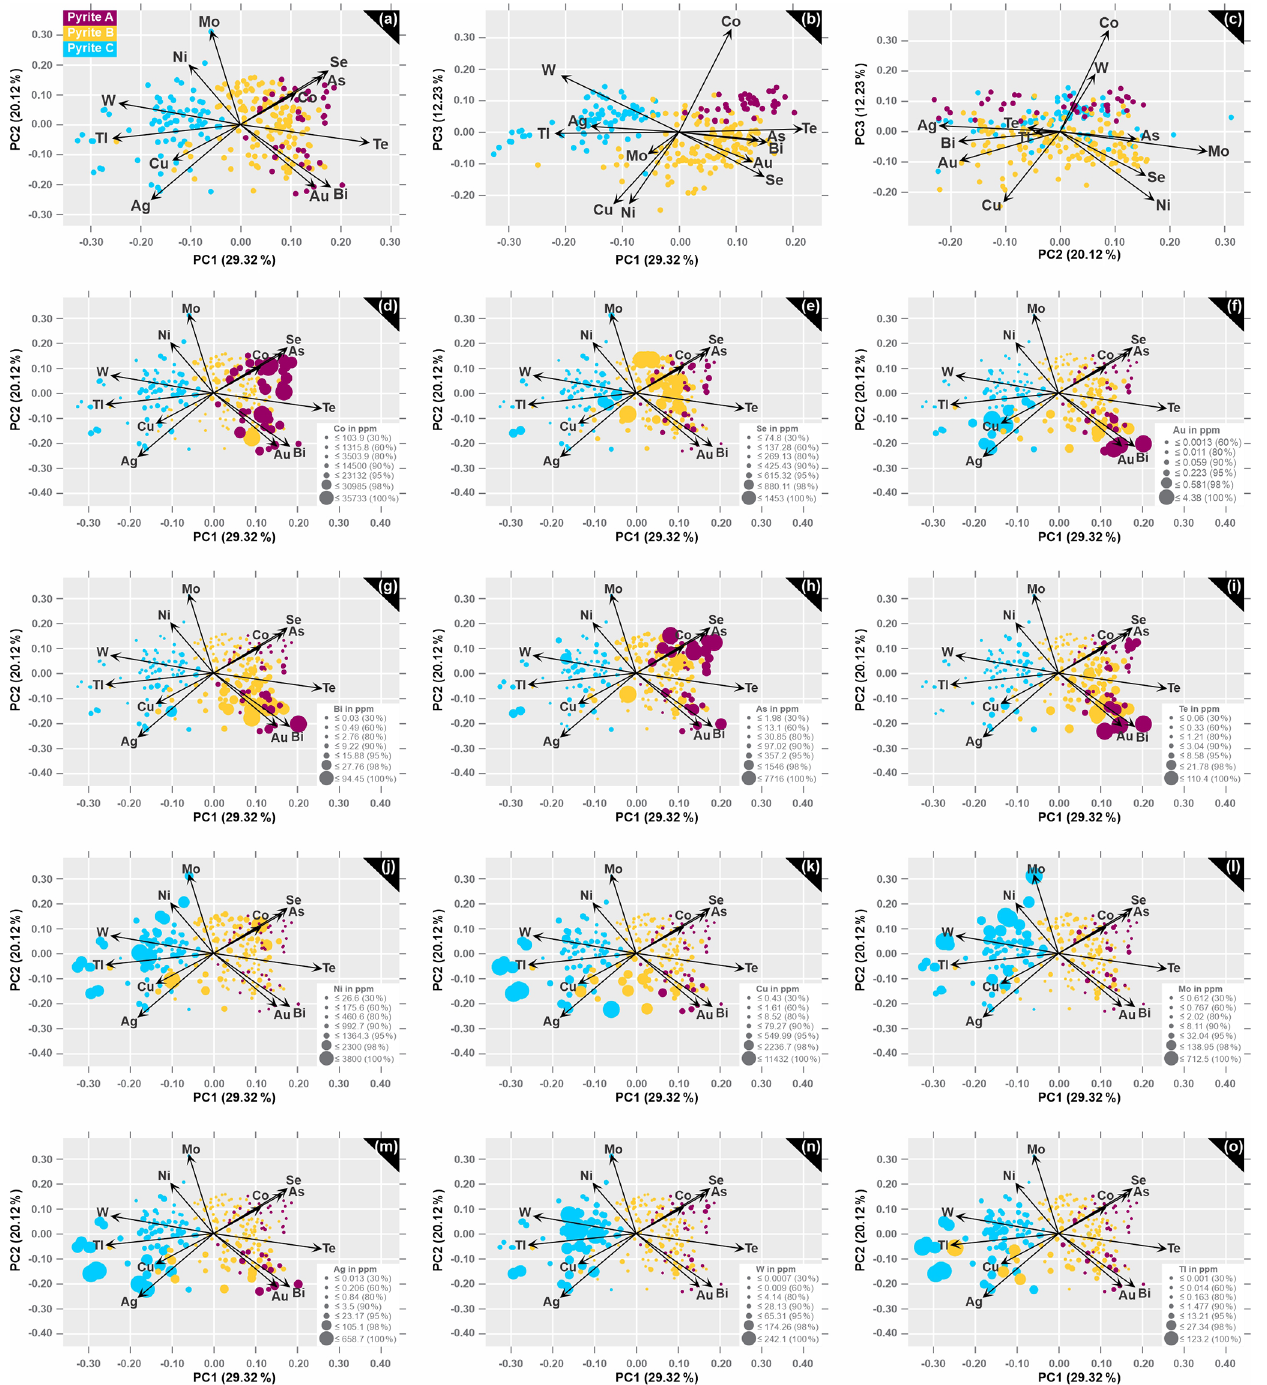
Figure 12. Principal component loadings (arrows) and scores (observations) of clr transformed n = 260 data. Original data are the analysis of pyrite A, B and C by LA-ICP-MS. Biplots illustrate the projections of the first three principal components: (a) PC1 versus PC2 (49.44% of the data variability), (b) PC1 versus PC3 (41.55% of the data variability) and (c) PC2 versus PC3 (32.35% of the data variability. PC1–PC2 projection in correlation with concentrations of (d) Co, (e) Se, (f) Au, (g) Bi, (h) As, (i) Te, (j) Ni, (k) Cu, (l) Mo, (m) Ag, (n) W, and (o) Tl.